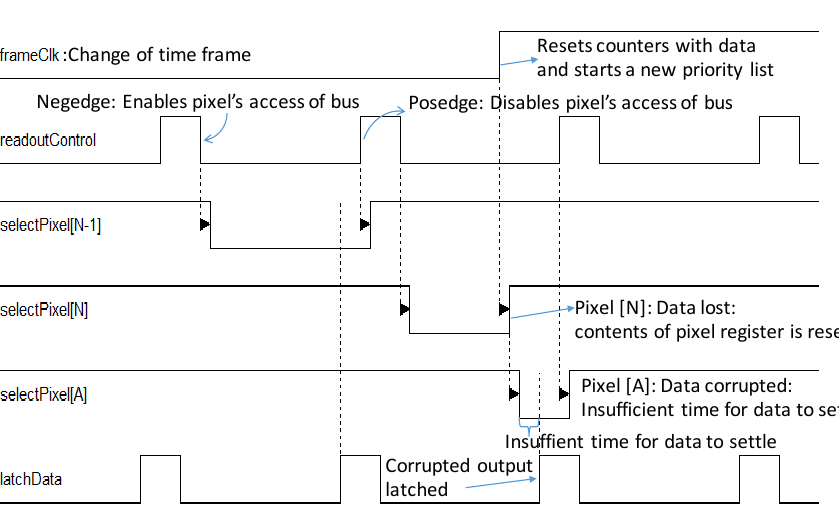
Figure 9. At frameClk change the contents of the pixel register currently being readout are reset, resulting in data loss. The priority encoder subsequently enables the first pixel from a new priority list. However, there is insufficient time for the data to settle, again resulting in corrupted data. The change of frameClk therefore requires a mechanism to ensure no data loss or